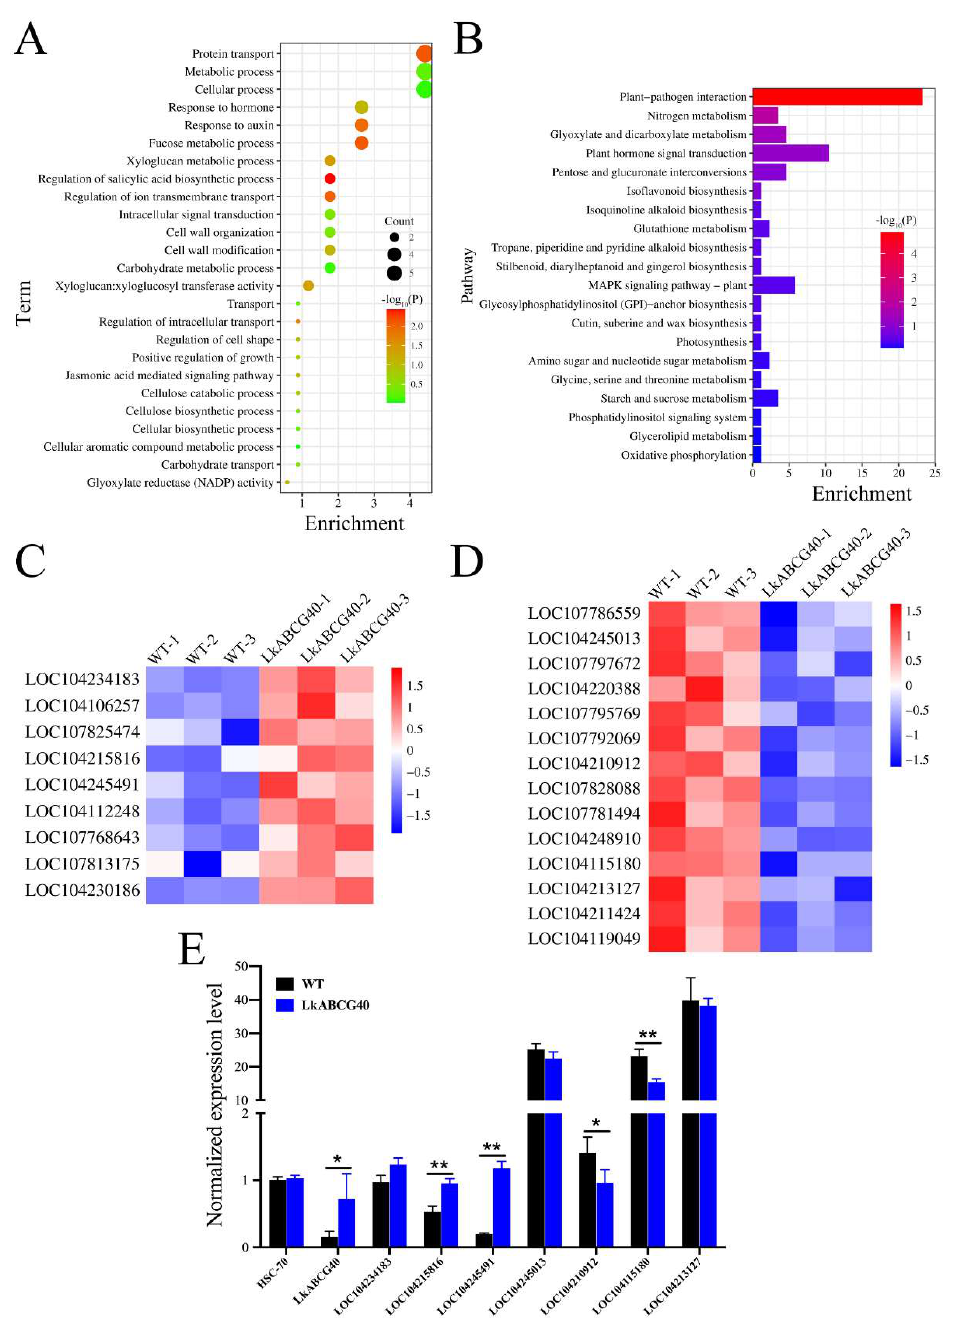
Figure 5. Functional enrichment analysis of DEGs and expression of key genes in LkABCG40 group. ( A ) Gene Ontology (GO) enrichment analysis identifiers in cluster of overlapping DEGs in LkA-